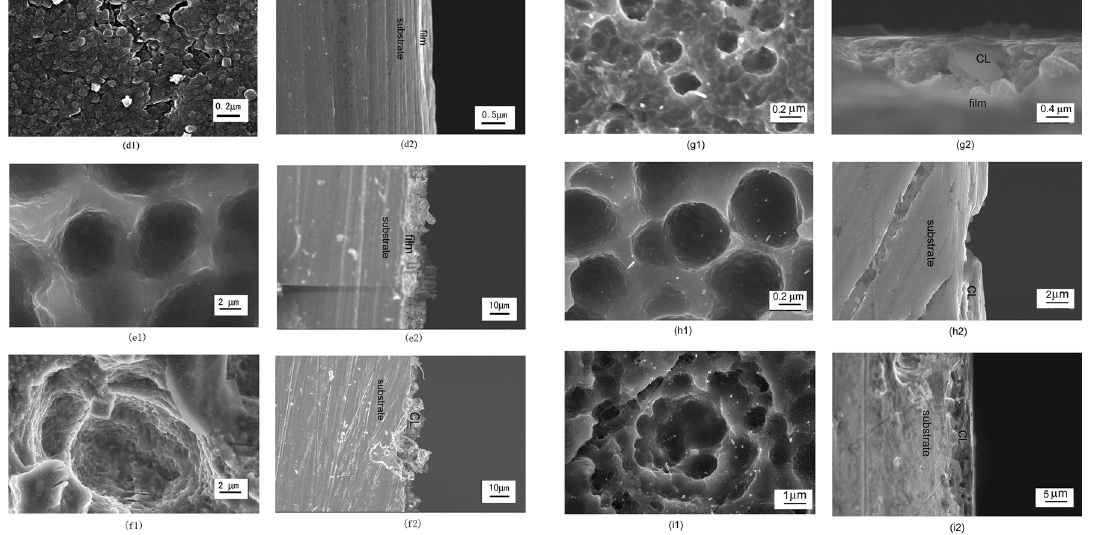
Figure 7. The surface and section morphology images of TiO samples observed by SEM after corrosion experiment in SBF (g, h and i are corresponding to 3 days, 7 days and 10 days corrosion, respectively. The left column of the figure is corresponding to surface morphology and the right column corresponding to section